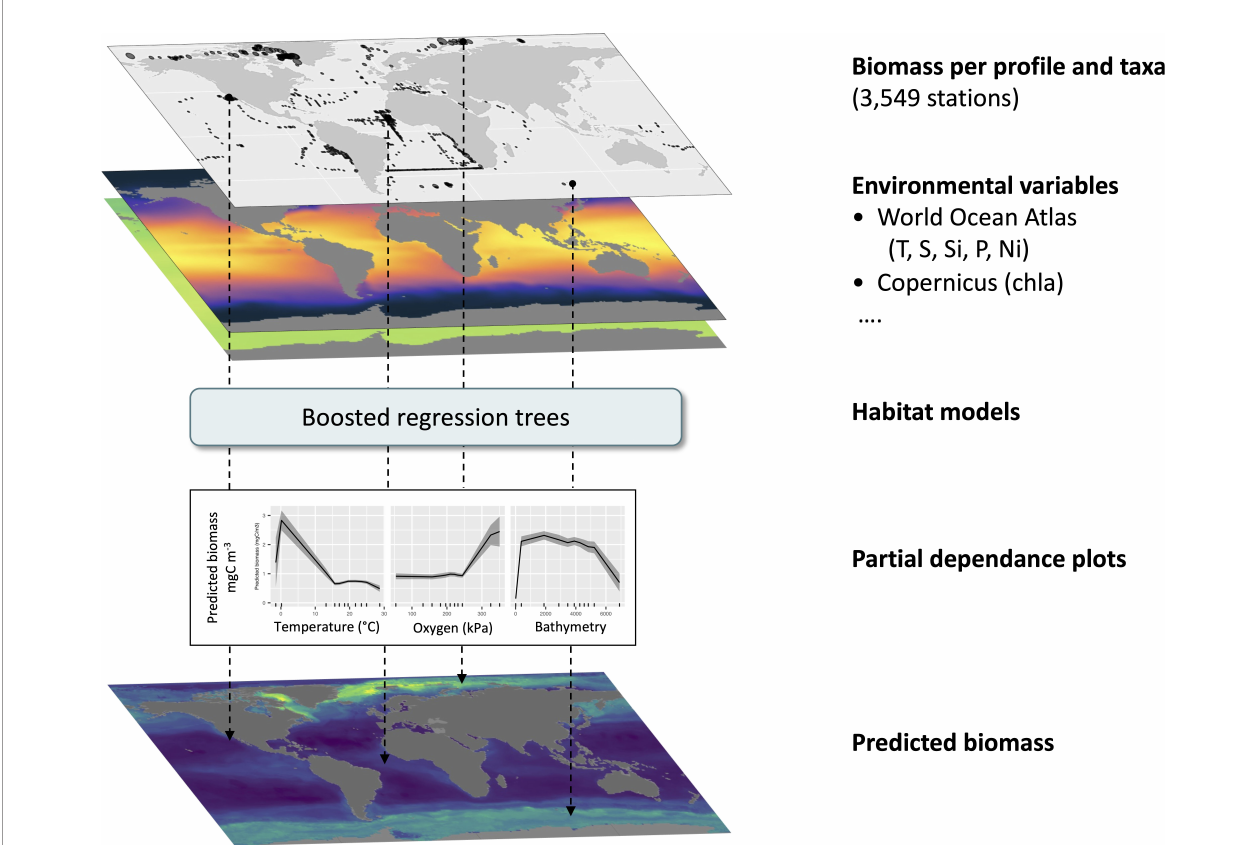
FIGURE 2 | Methodology followed from data selection to prediction of global